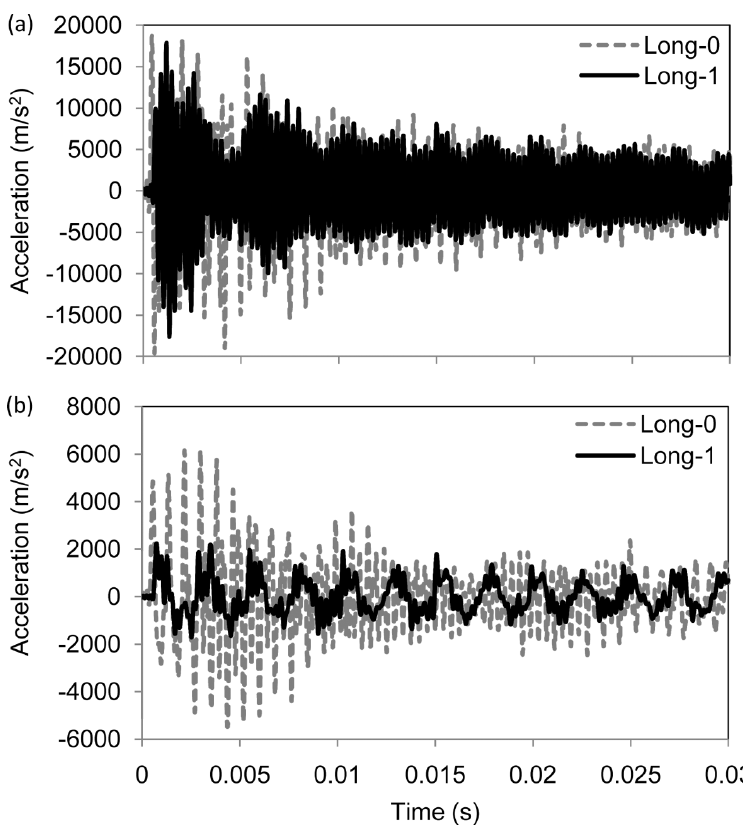
Fig. 10. Experimental results of acceleration responses of long structures under impact loading using (a) hard and (b) medium tip impacts. 5,000 Hz cutoff frequency is used for low-pass fi